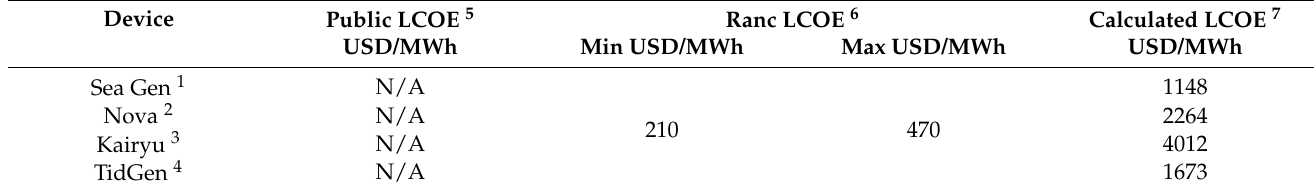
Table 6. LCOE for the turbines using the maximum Capacity Factor at node